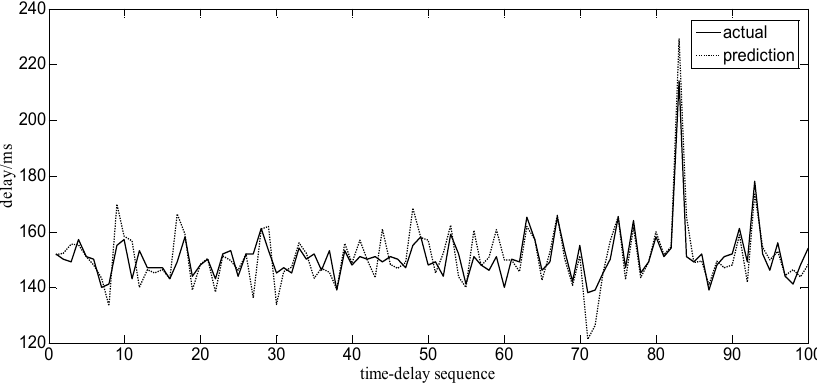
Figure 9. Auto regression (AR) time-delay prediction result.